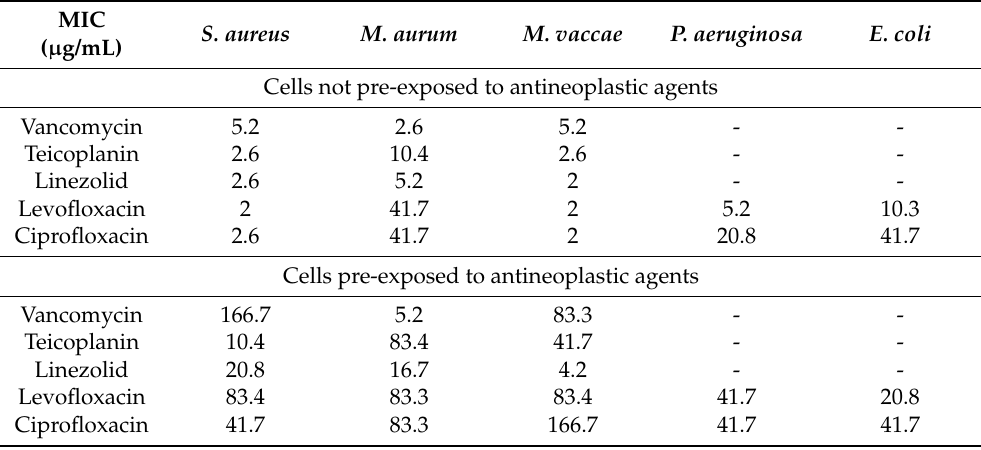
Table 2. Minimum inhibitory concentration of antibiotics against bacteria pre-exposed and not pre-exposed to the antineoplastic mitomycin C. MICs were determined in three independent assays. MIC ( µ